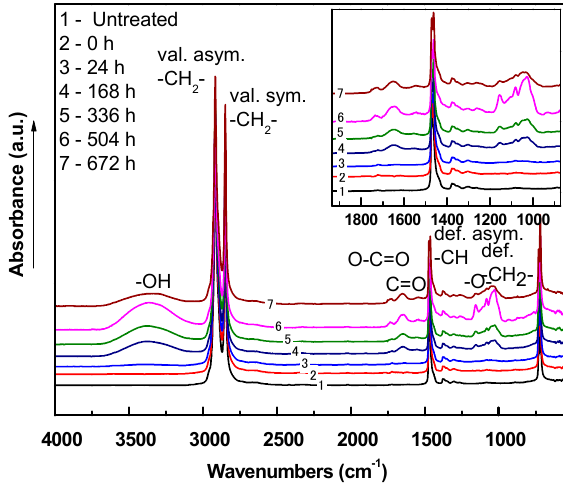
Figure 14. FTIR spectra of LDPE plasma treated for 120 s using oxygen and stored in air.